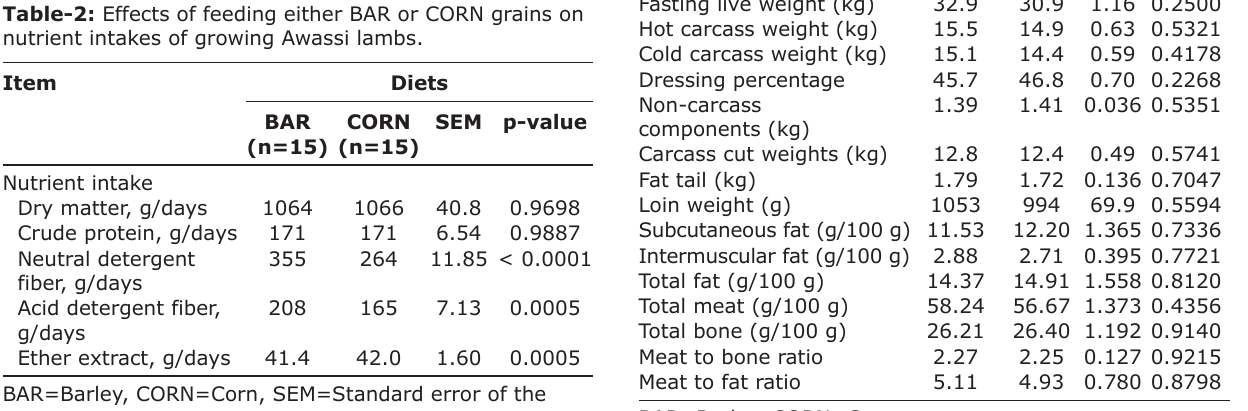
BAR=Barley, CORN=Corn, SEM=Standard error of the mean